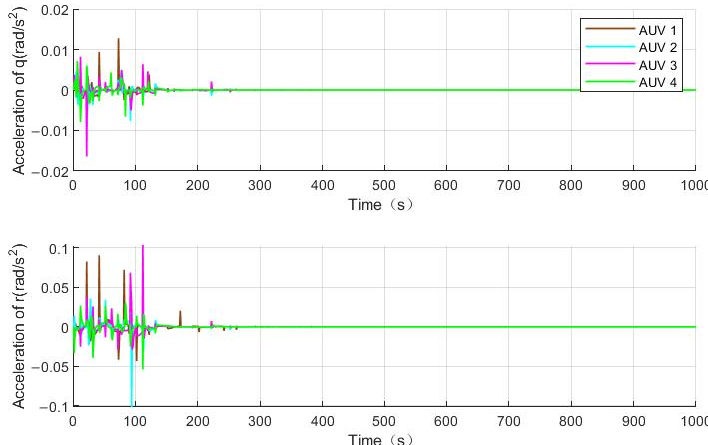
Figure 10. Linear acceleration status of followers.